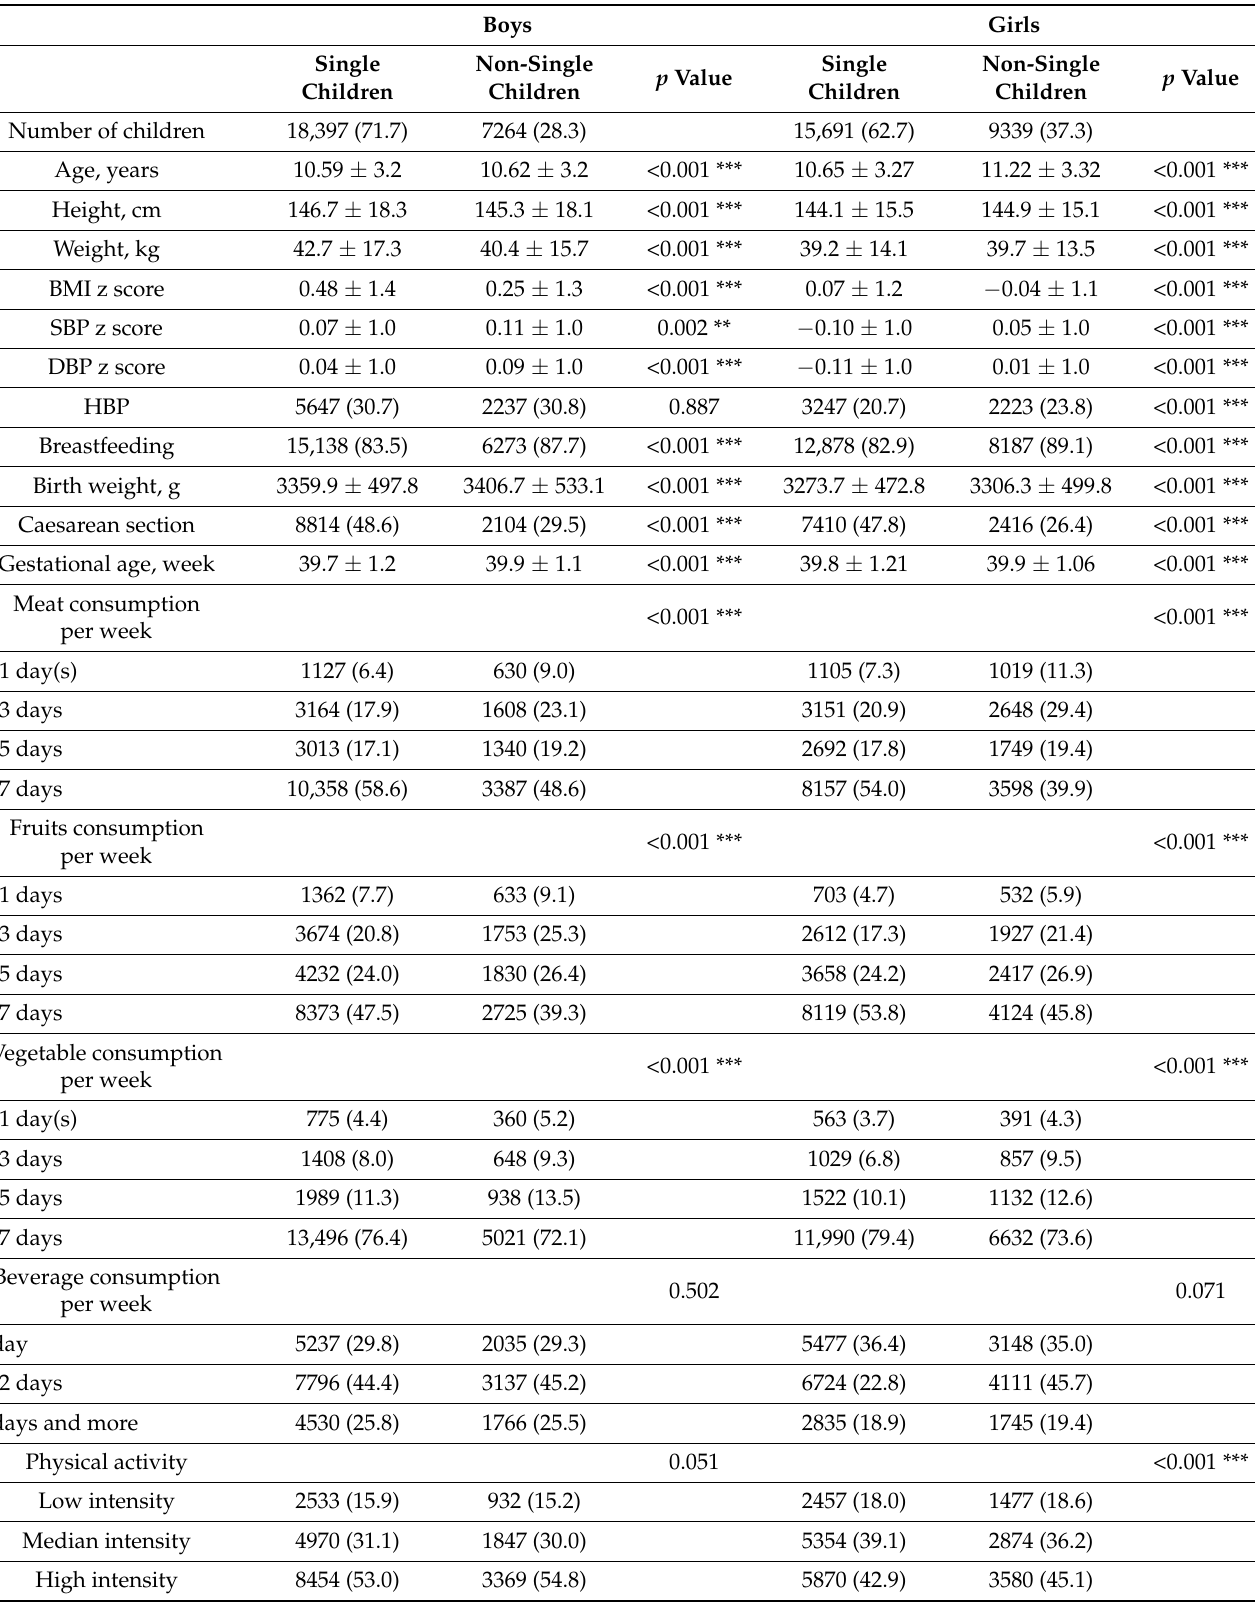
Table 1. Characteristics of participants involved according to single-child status and by sex ( n =